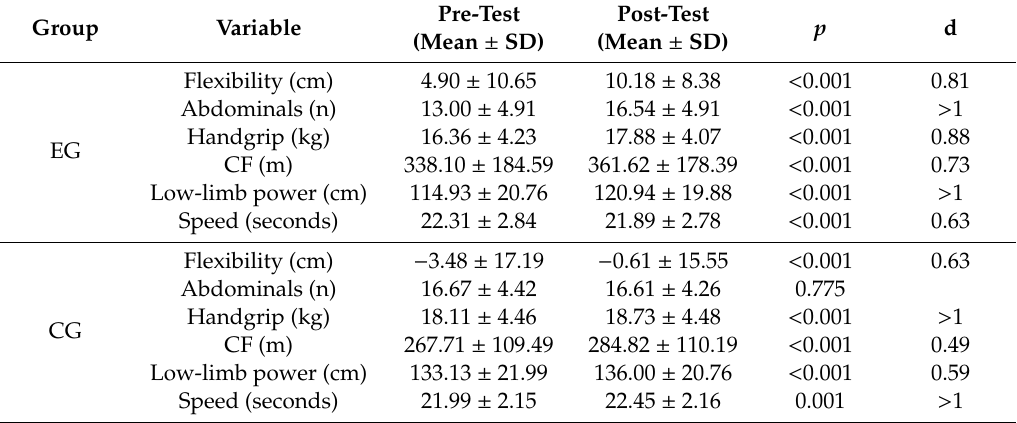
Table 3. Results of the paired pre-post-test comparison for the experimental (EG) and the control group (CG).